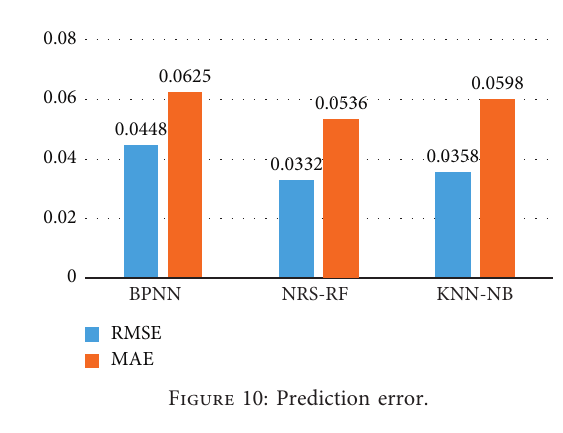
Figure 10: Prediction error.